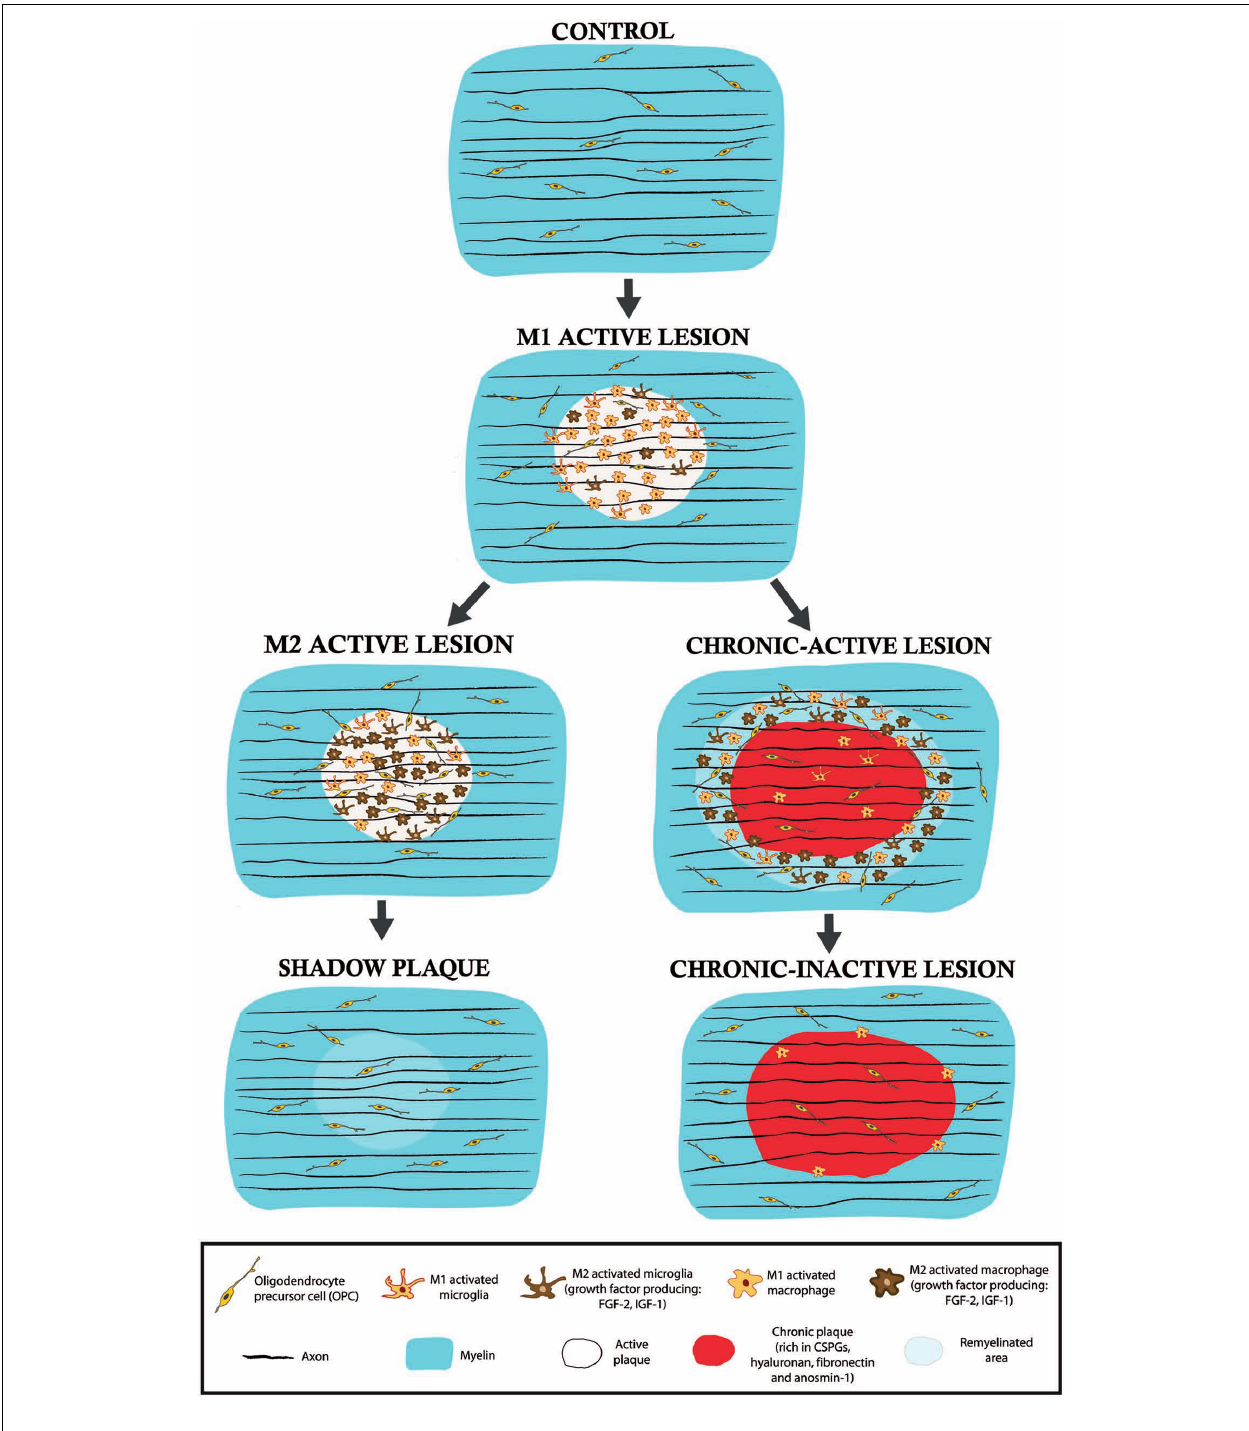
FIGURE 2 | Schematic drawings of the different types of lesions in the MS white matter. M1 active lesions are characterized by the presence of microglia/macrophage in a pro-inflammatory activity state. In these lesions, remyelination does not occur and demyelination advances. According to the results observed in a murine model of focal demyelination (Miron etal., 2013), an active lesion may derive into a M2 predominant activity state and thus, microglia/macrophages would change their phenotype and begin to release pro-regenerative molecules, such as the growth factors IGF-1 or FGF-2. If this